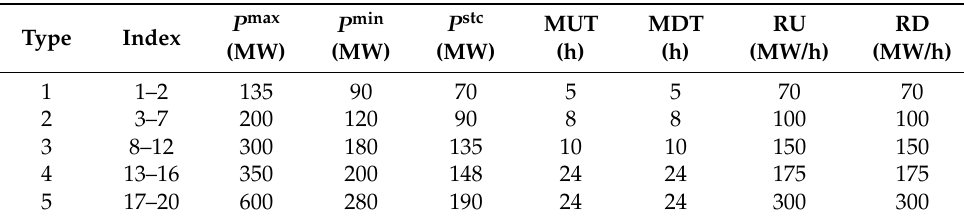
Table 1. Technical parameters of the units.